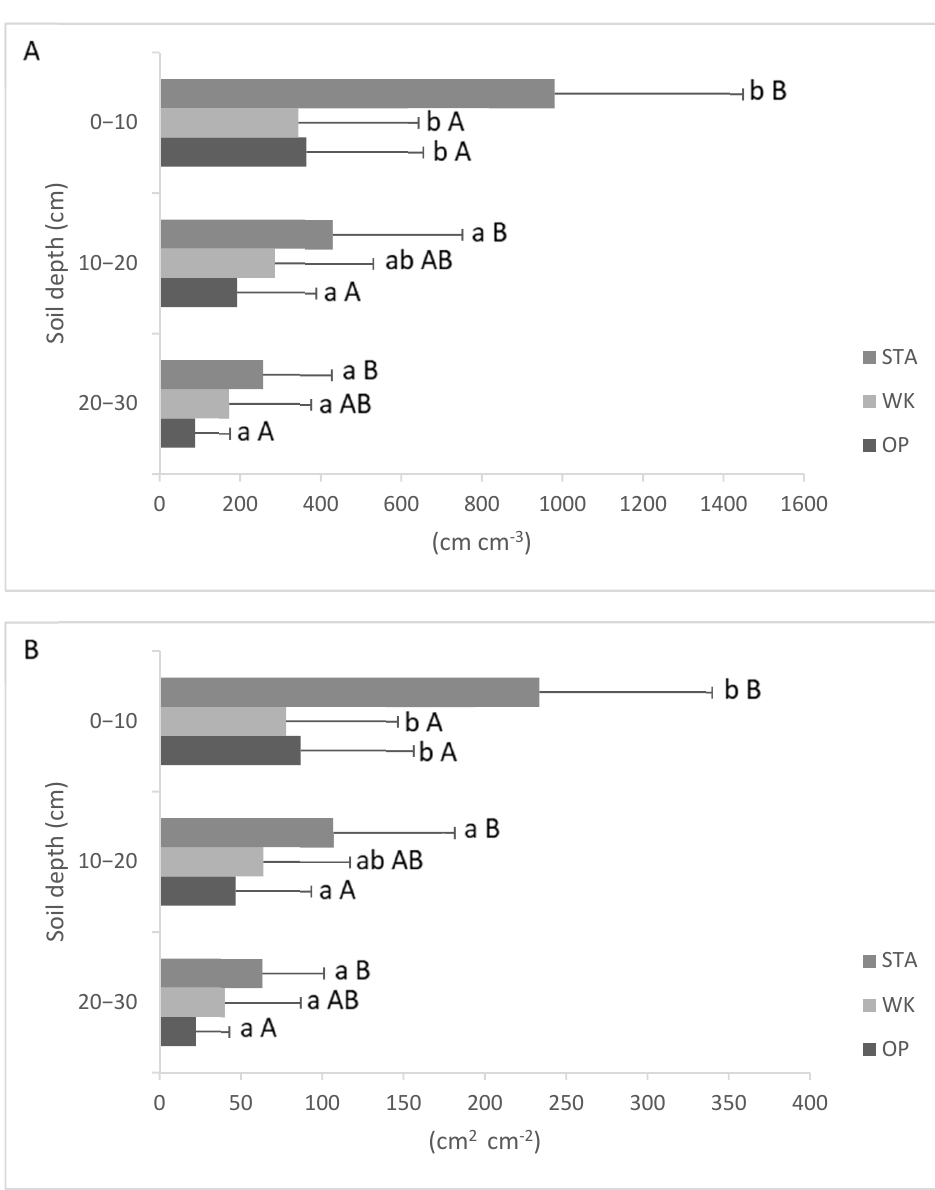
Table 4. Results of a three-way ANOVA (F and p -values) on the influence of three study sites (STA, WK, OP), three different soil depths, and two variable seasons (spring, autumn) on various fine root architecture traits in three riverside forests.